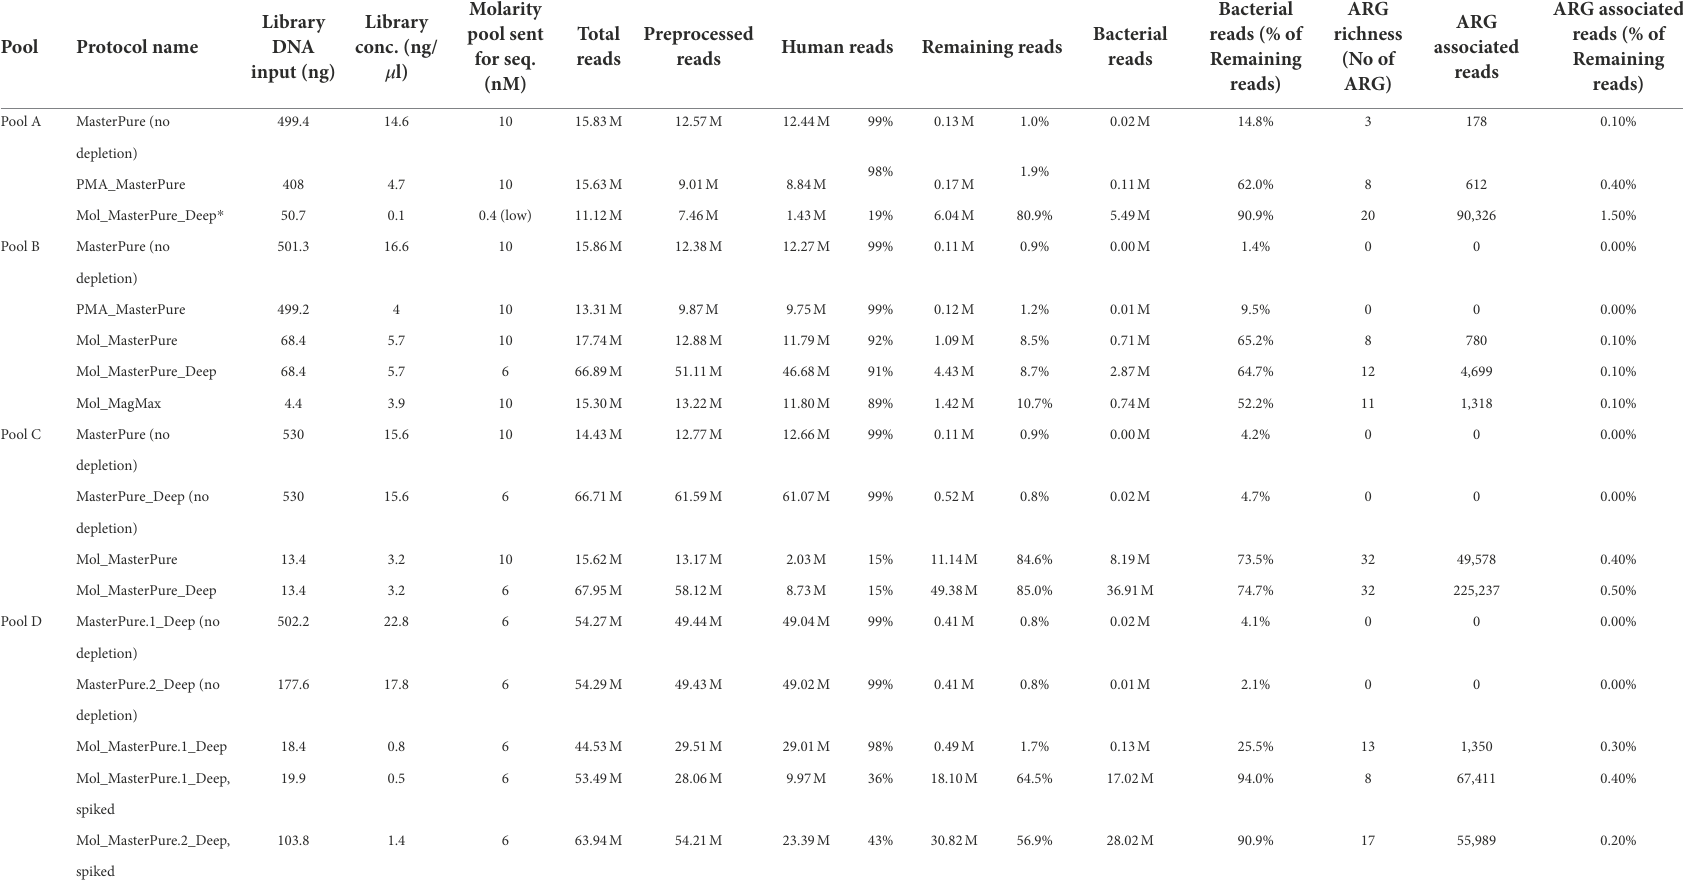
TABLE 2 Information regarding library preparation, host DNA content and number of bacterial, and ARG associated